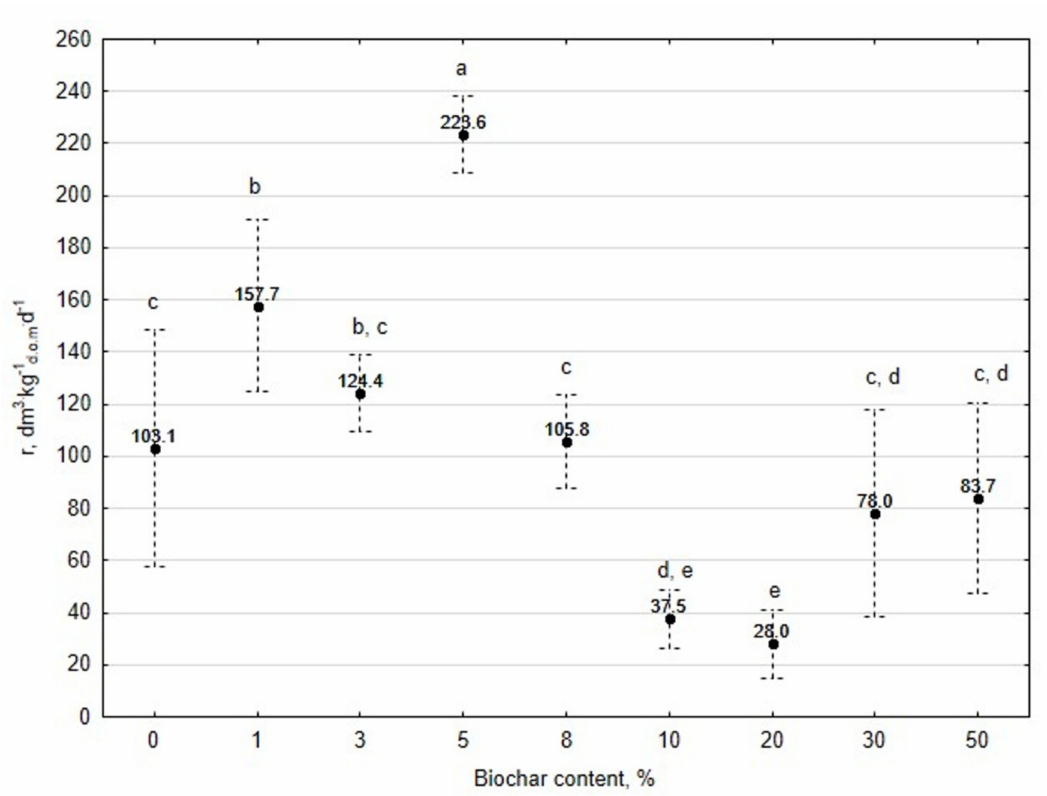
Figure 5. The influence of biochar (BC) mass content (%) addition to brewer’s spent grain (BSG) digestion and biogas production rate ( r ), dm 3 · kg − 1 d.o.m. · d − 1 . Letters show significant di ff erences ( p < 0.05) between mean